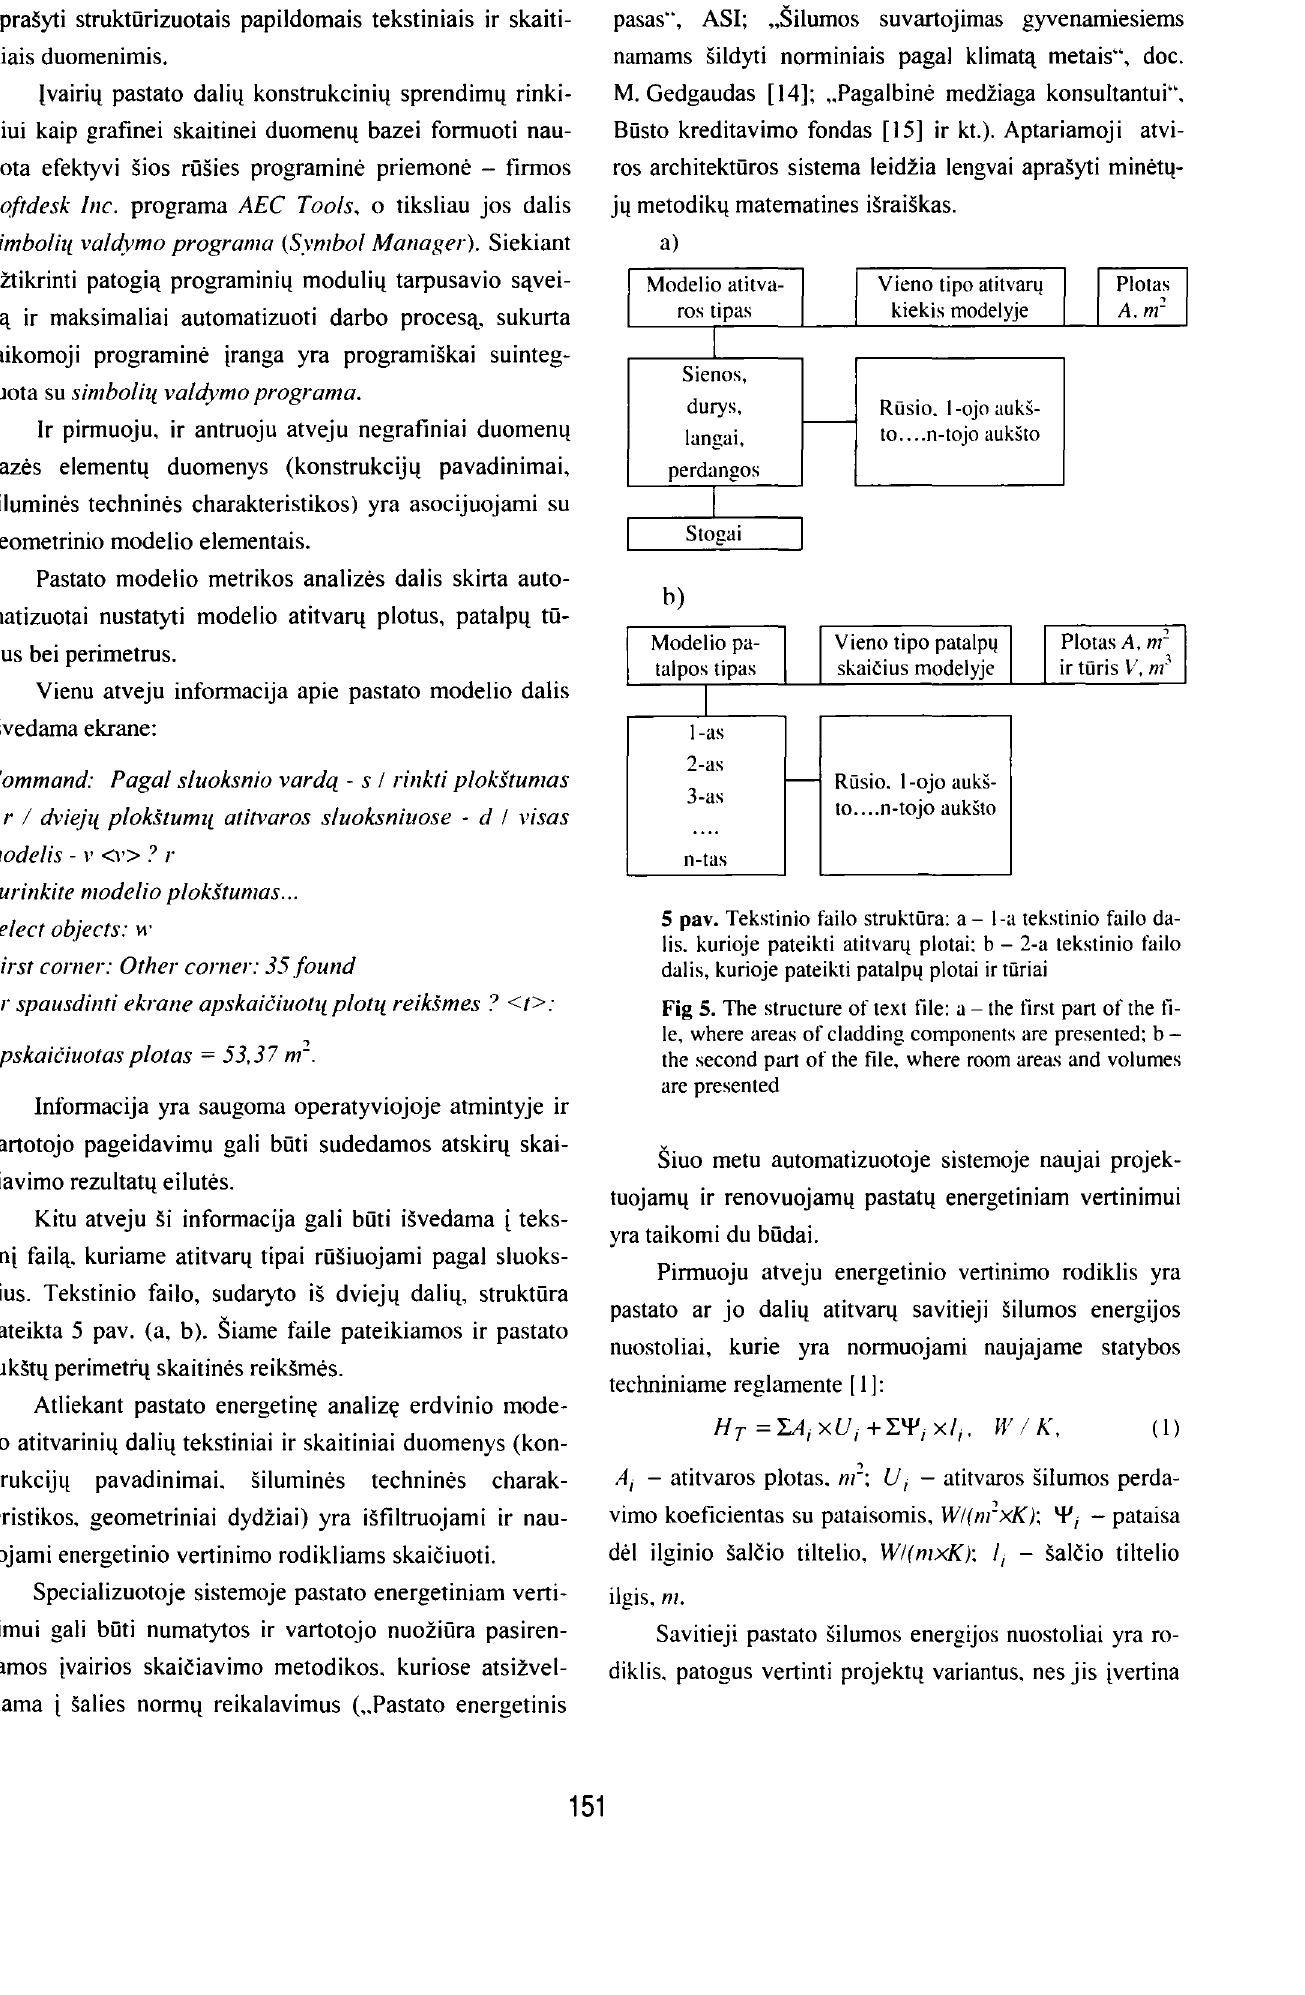
Fig 5. The structure of text tile: a- the first part of the ti le, where areas of cladding components are presented: b - the second part of the file, where room areas and volumes are